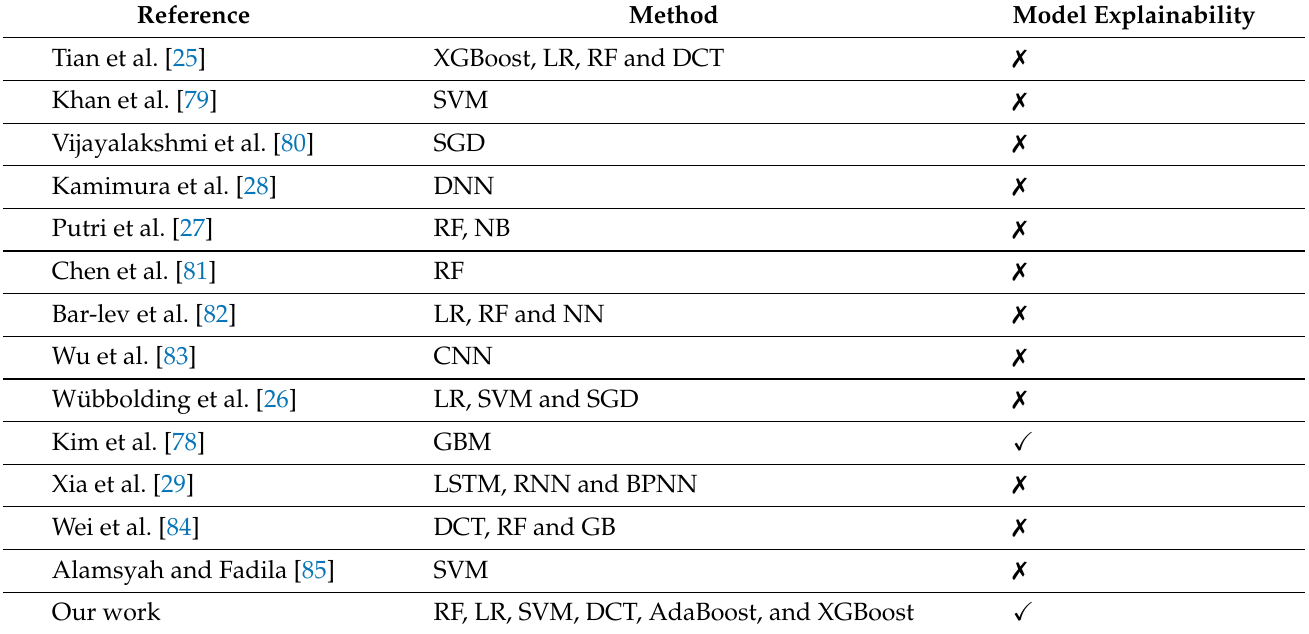
Table 3. Comparison with other